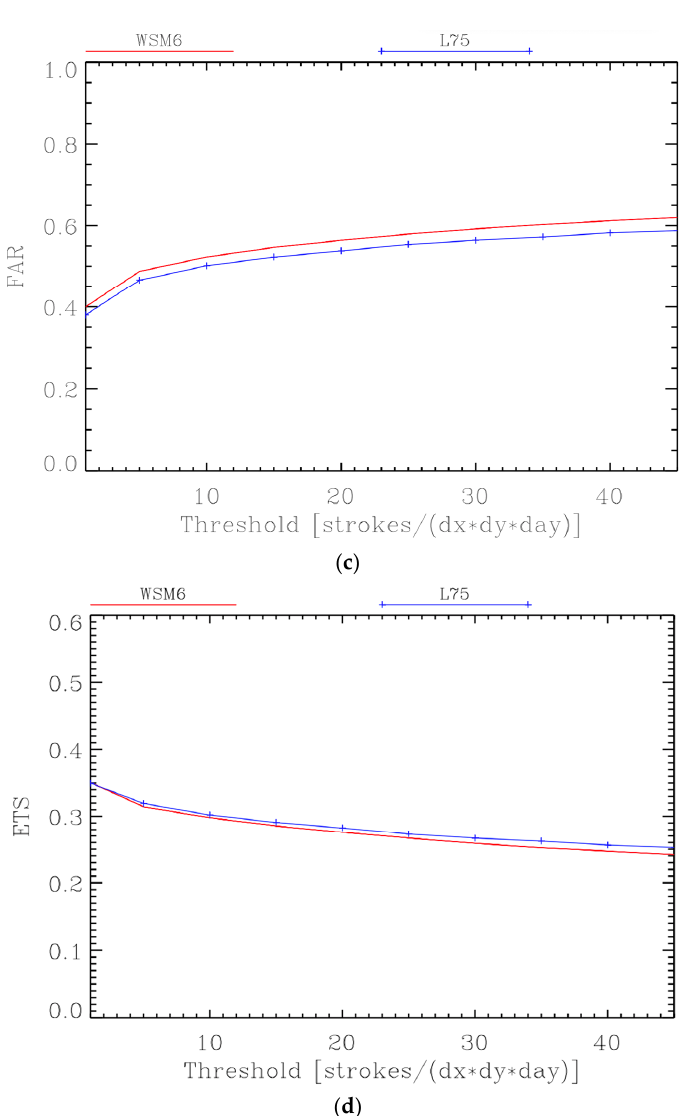
Figure 9. ( a ) FBIAS, ( b ) POD, ( c ) FAR, and ( d ) ETS for different lightning thresholds ( x -axis) for L75 (blue curves) and the same charge configuration using the WSM6 microphysical scheme (red curves). Scores are shown for 24 km grid cells.